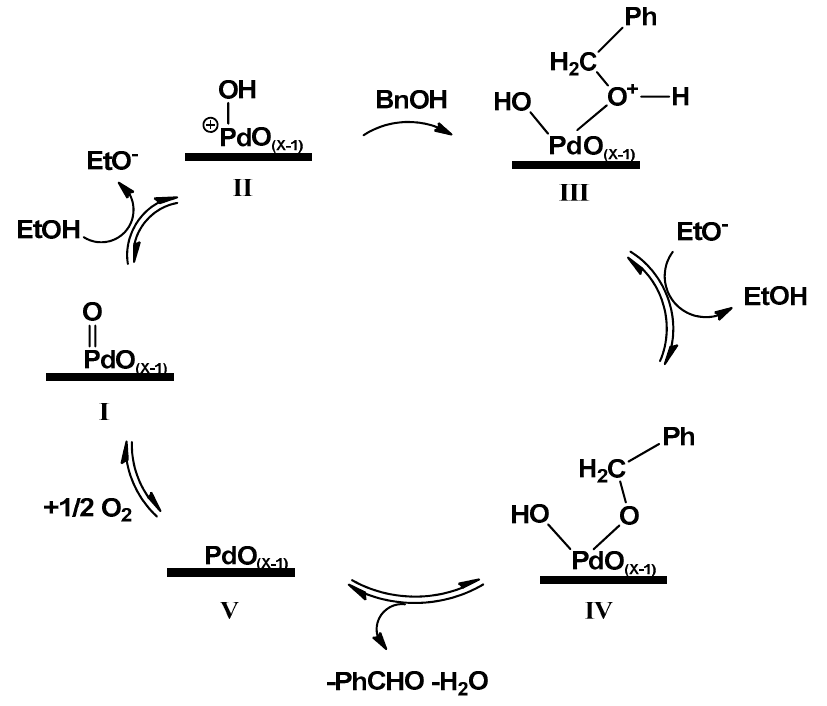
Figure 7. BnOH conversion using PdO x /CeO 2 -NR or PdO x /CeO 2 -NR-Red catalysts, as a function of time. Reaction conditions: BnOH 0.16 mmol, catalyst mass 32 mg, reaction temperature 78 °C for ethanol and 111 °C for